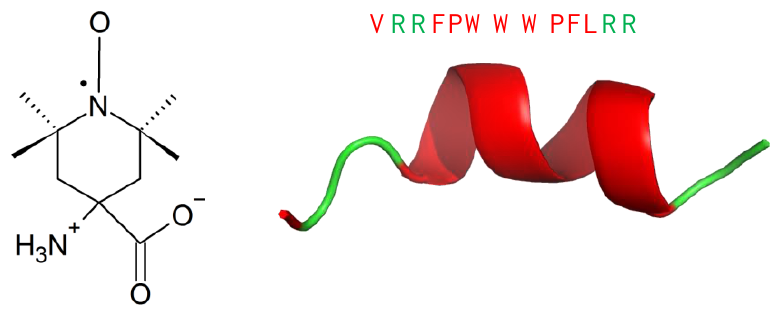
Figure 24. Chemical structure of TOAC (left) and secondary structure of TRP3 calculated with I-Tasser. In green: positively charged amino acids; in red: hydrophobic amino acids.